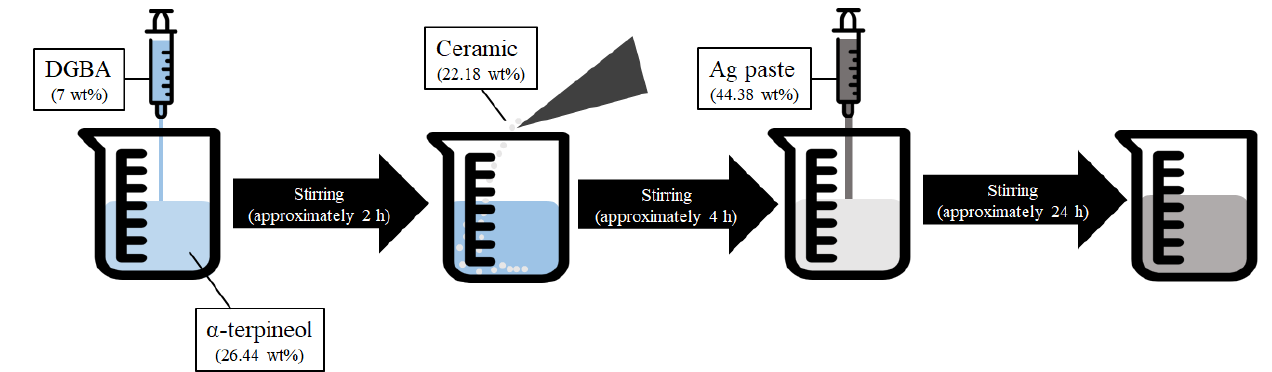
Figure 1. Fabrication mechanism of inks for EHD ink-jet printing.